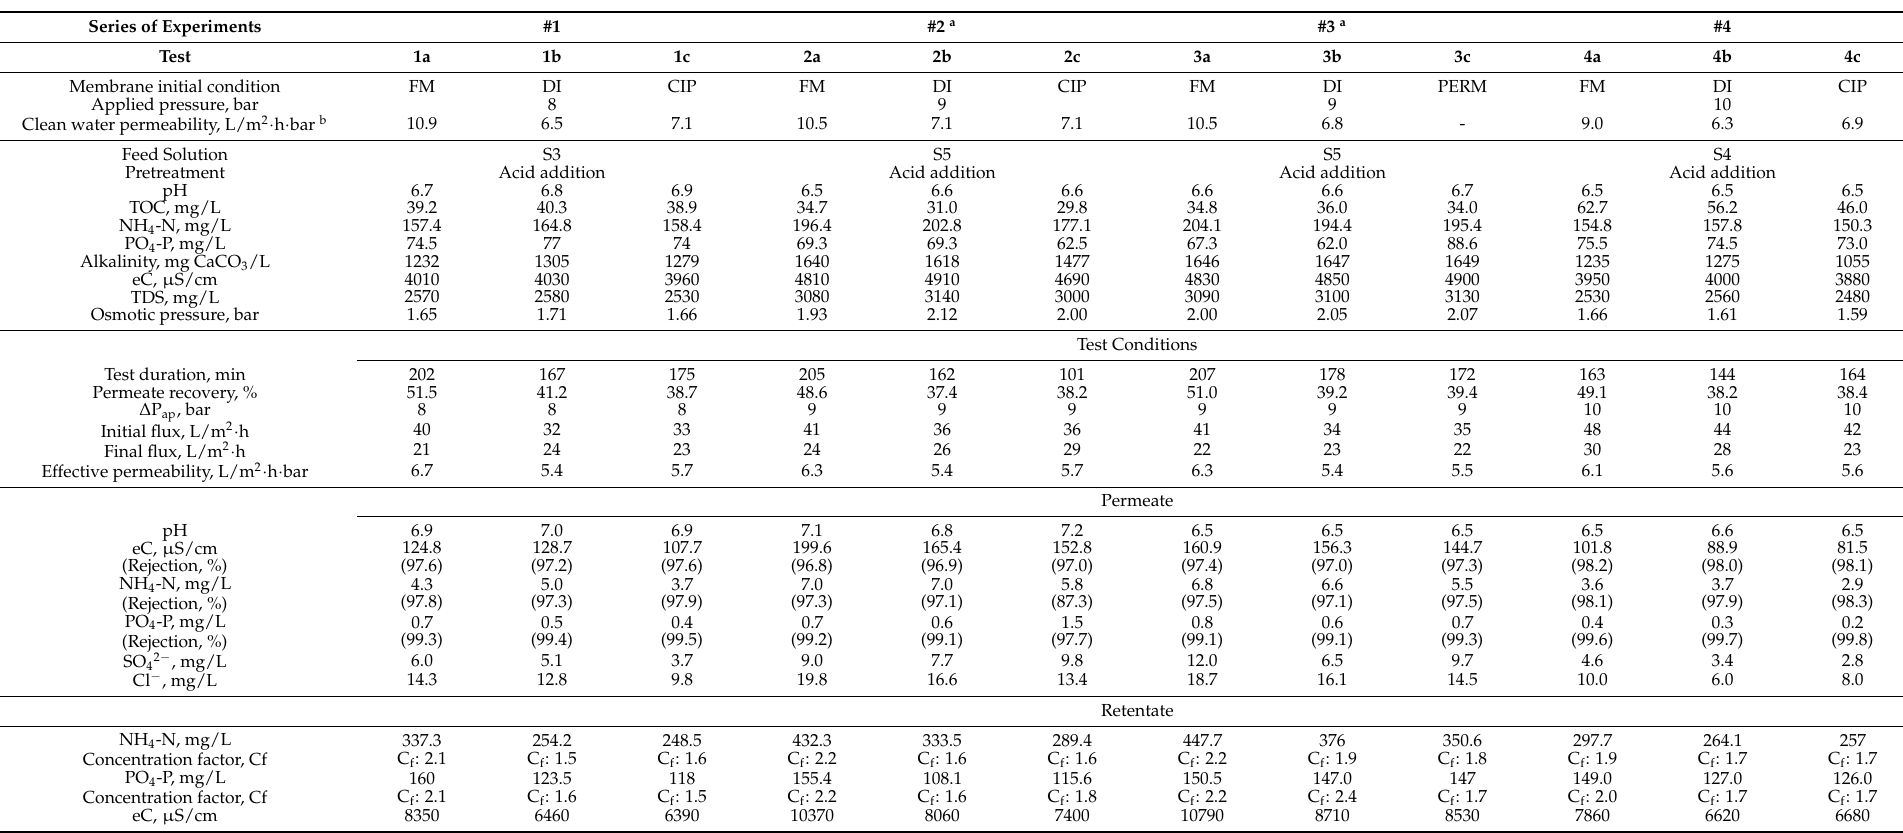
Table A4. Main physicochemical parameters of Filtered Liquid Digestate (FLD), pretreated with H 2 SO 4 . Conditions and key process-parameter values of the test series performed for evaluation of the membrane performance in actual conditions. Cross-flow velocity: 20 cm/s, unless otherwise